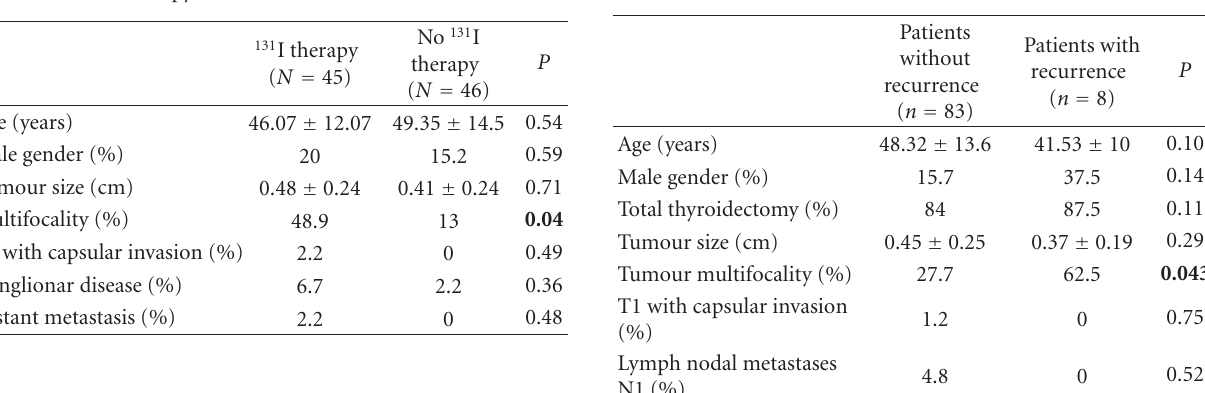
Table 2: Comparison between the main characteristics patients who received 131 I therapy and those who did not.